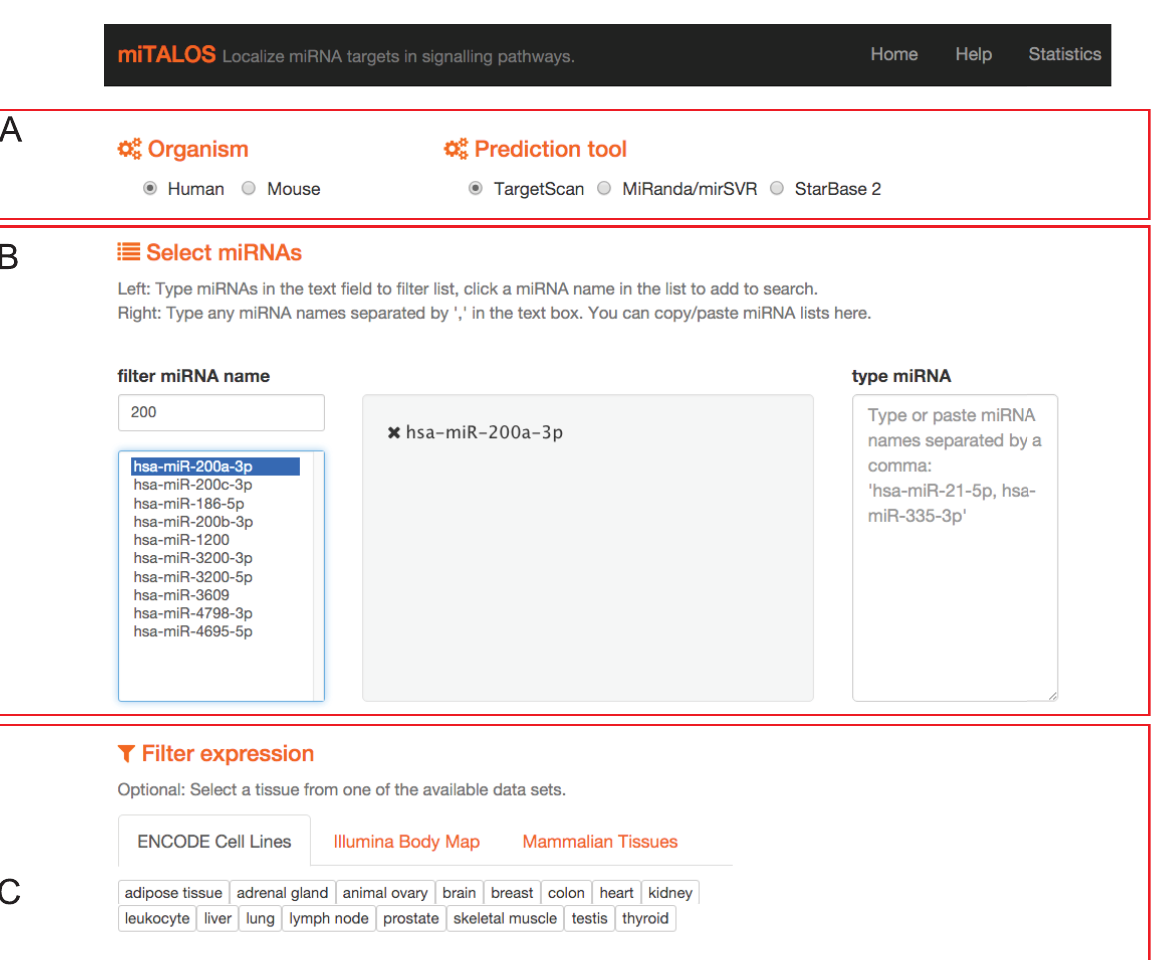
Fig 4. User interface of miTALOS v2. (A) The user starts by selecting the organism and miRNA prediction tool. Next, multiple miRNAs can be selected by filtering the list of available miRNAs (B). Lastly, a tissue filter can be applied by selecting an expression experiment and tissue or cell line